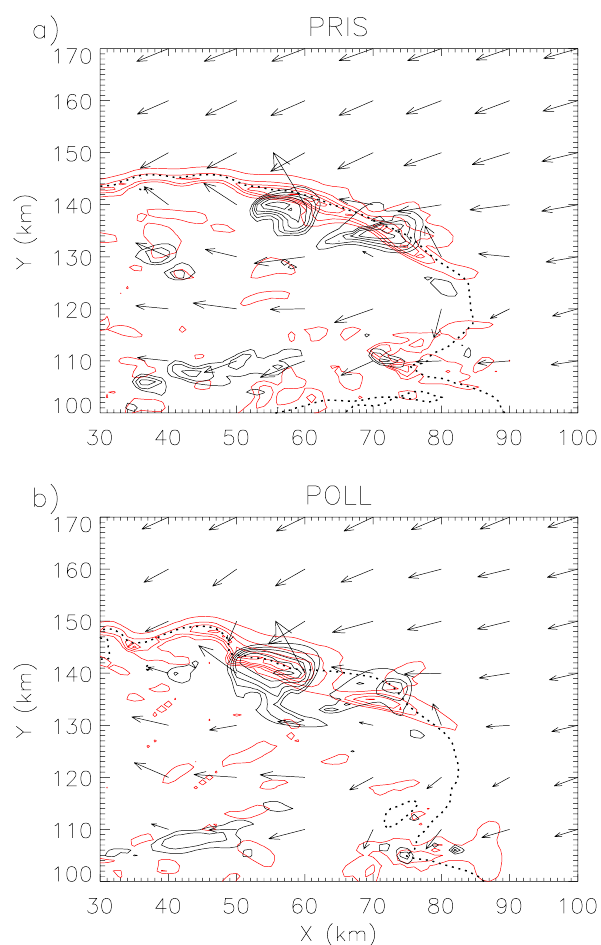
Fig. 8. Upward vertical velocity at altitudes of 1.5km (red contours) and 5km (black contours), storm-relative low-level horizontal wind (vectors), and cold pool boundary denoted by the − 2K θ 0 isotherm (black dotted contour) for the BASE configuration at t = 120min and (a) pristine (PRIS) and (b) highly polluted (POLL) conditions. Contour intervals are 5ms − 1 for the 5km vertical velocity (con- tours starting at 5ms − 1 ) and 2ms − 1 for the 1.5km vertical veloc- ity (contours starting at 1ms − 1 )